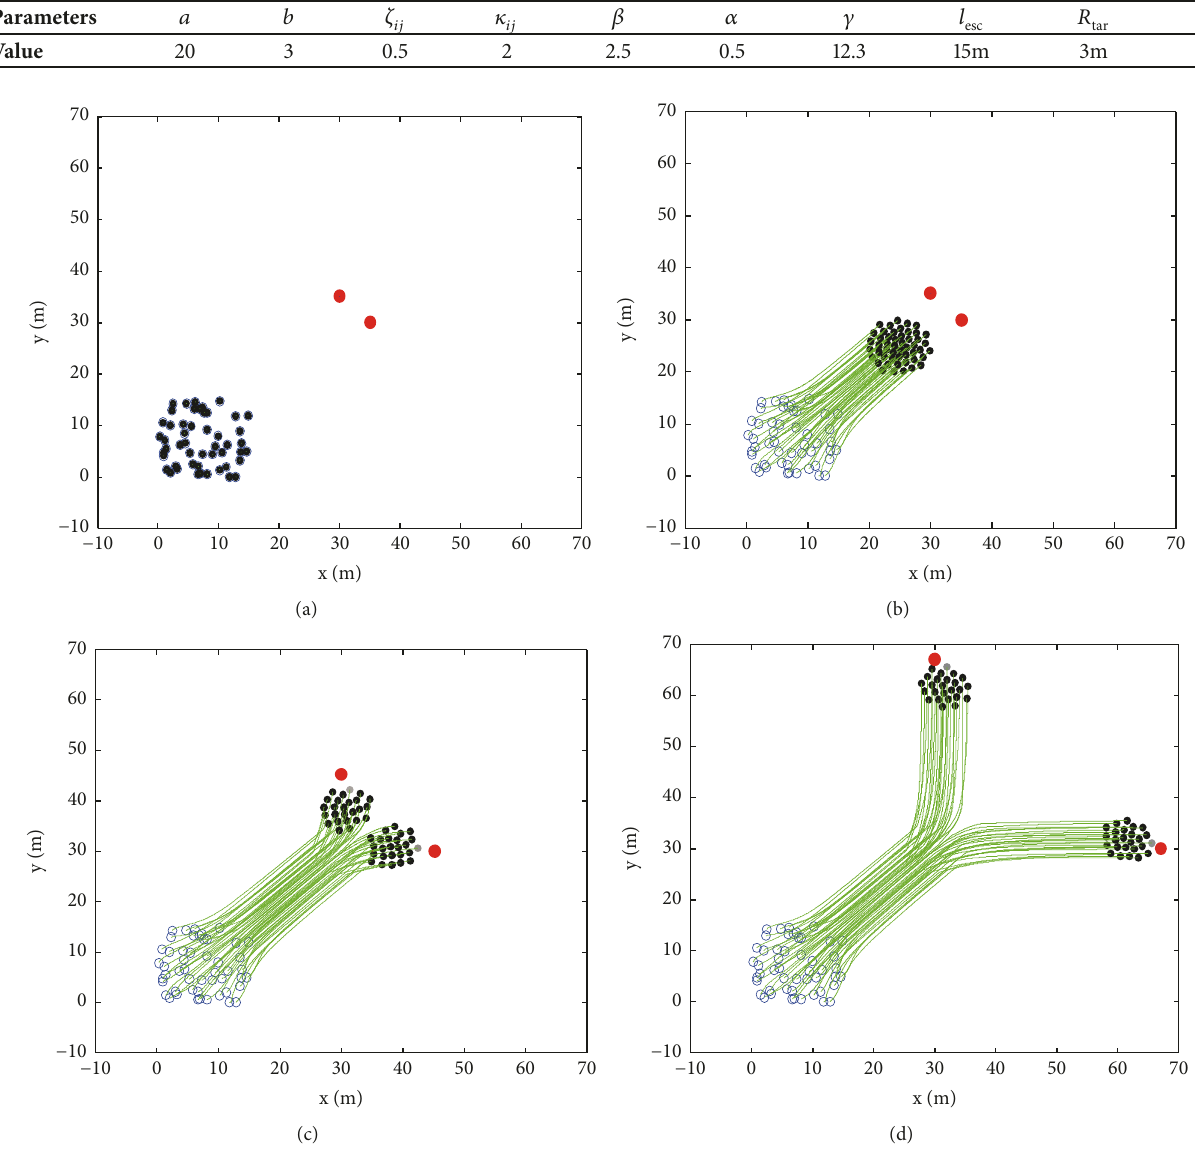
Figure 2: Trajectory of individuals in the fusion-fission process. The blue hollow circles denote the initial positions of individuals, black solid circles demonstrate their final positions, green lines represent the trajectories of individuals, red solid circles are the position of two targets, and gray solid circles are the individuals that firstly sense the